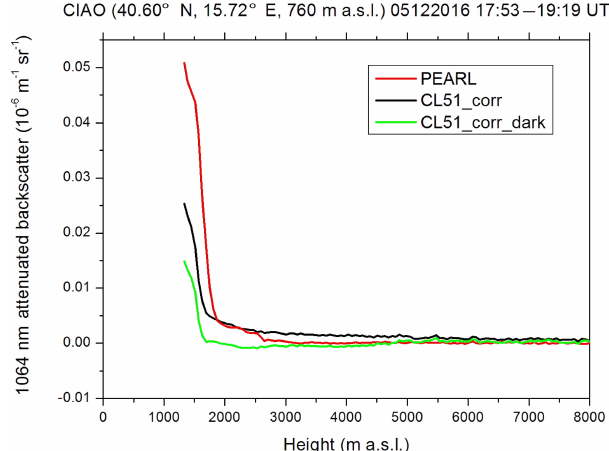
Figure 10. Comparison among the attenuated backscatter profile retrieved from PEARL (red), from CL51 accounting for the water vapor absorption at its operating wavelength (dark) and from CL51 subtracting the dark current measured separately and then account- ing for the water vapor absorption (blue) on 1 December 2016 in the time interval from 17:53 to